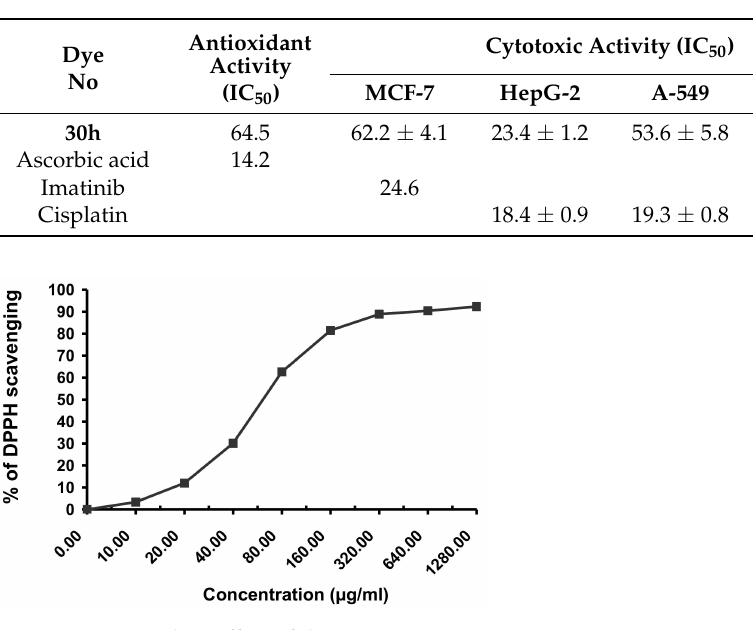
Table 9. Antitumor and antioxidant activities of dye 30h .